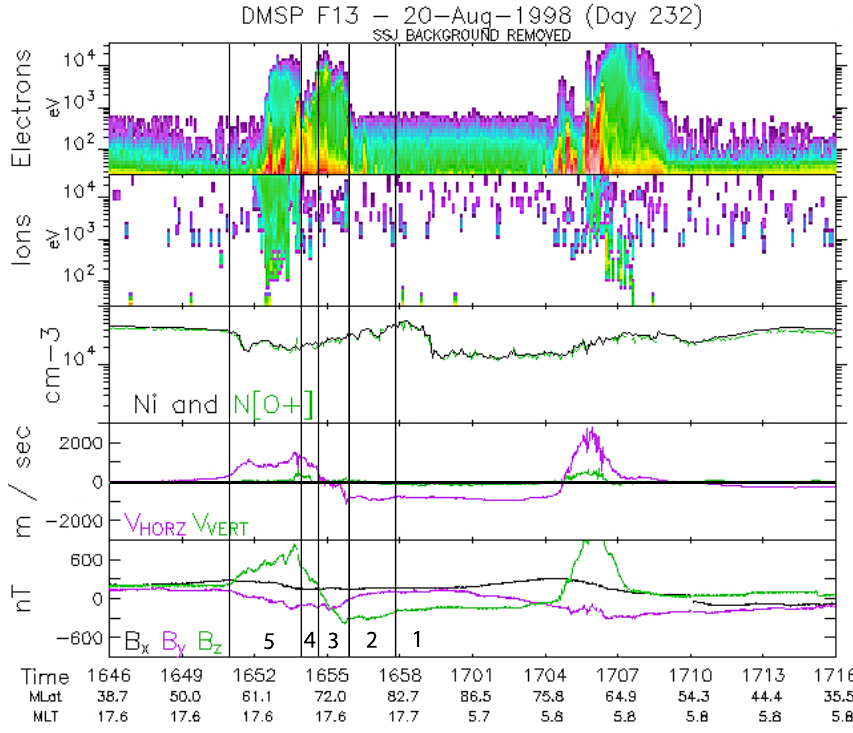
Fig. 14. Northern Hemisphere DMSP F13 data for the interval 16:46–17:16UT. Precipitation/convection/Birkeland current regimes marked 1–5 are: (1): P.RAIN (central polar cap); (2): P.RAIN and C1 current and moderate FC 2; (3): evening arcs and C2 current; (4): BPS and R1 current; (5): CPS and R2 current. Event category: NH-dusk/ B y < 0